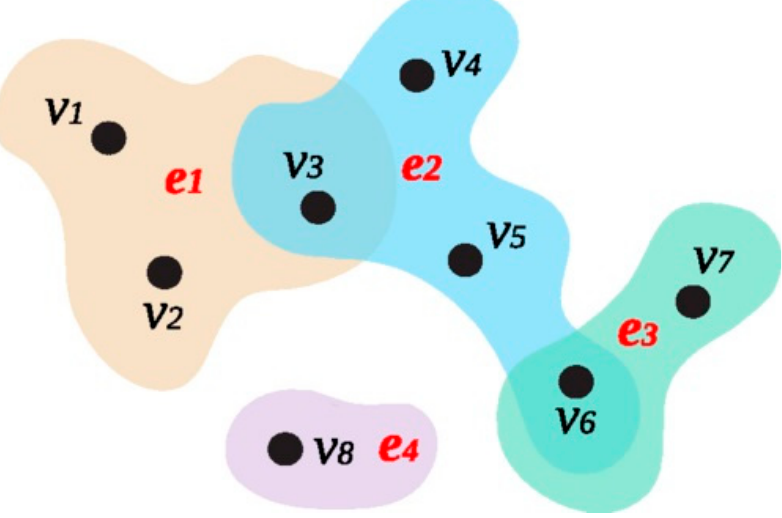
Figure 1. Graphical representation of a hypergraph. Mathematically, V = { v 1 , v 2 , v 3 , v 4 , v 5 , v 6 , v 7 , v 8 } , E = { e 1 , e 2 , e 3 , e 4 } , where the hyperedges are e 1 = { v 1 , v 2 , v 3 } , e 2 = { v 3 , v 4 , v 5 , v 6 } , e 3 = { v 6 , v 7 } , and e 4 = { v 8 }